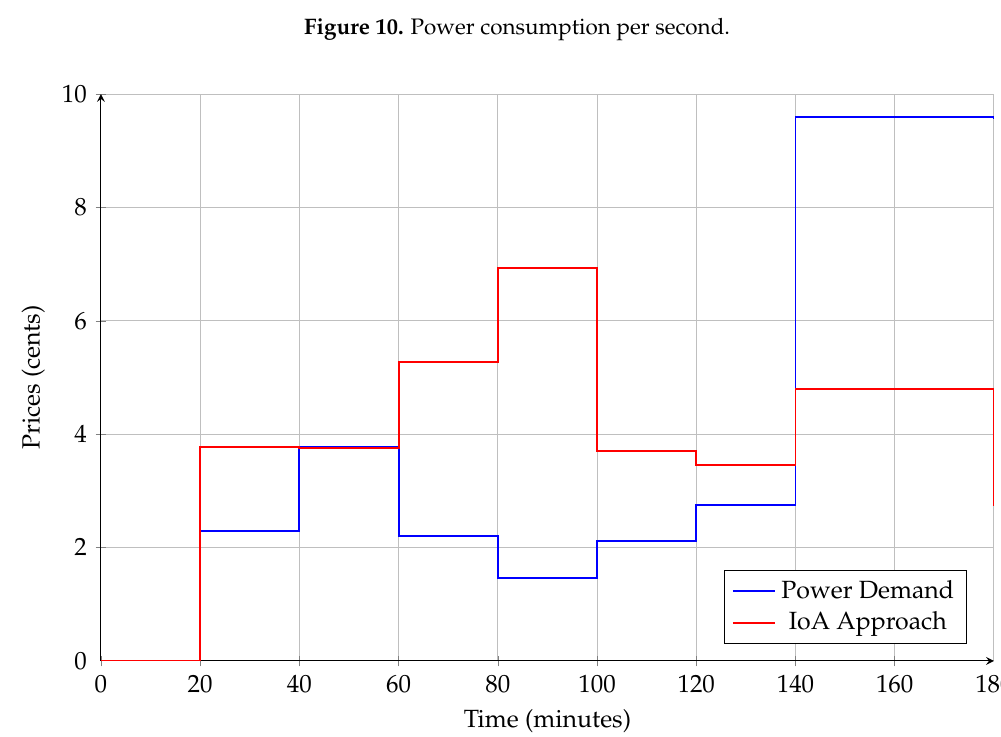
Figure 11. Cost consumption from 6:00 a.m. to 9:00